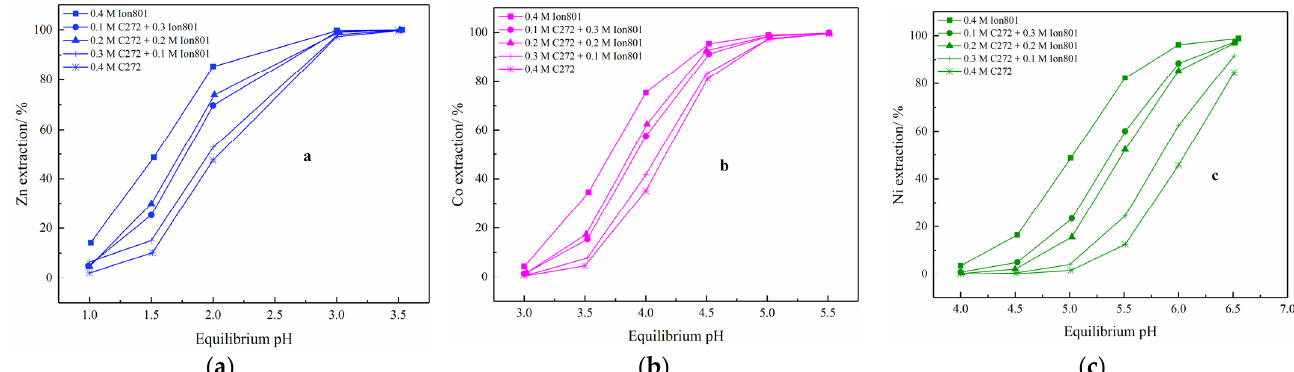
Figure 6. Metal extraction pH isotherms of mixed organic solutions of Cyanex 272 and Ionquest 801 at the total concentration of 0.4 M (in legends: number followed by concentration unit M, C272 is for Cyanex 272, and Ion801 is for Ionquest 801). ( a ) Zn extraction-pH, ( b ) Co extraction-pH, ( c ) Ni extraction-pH.